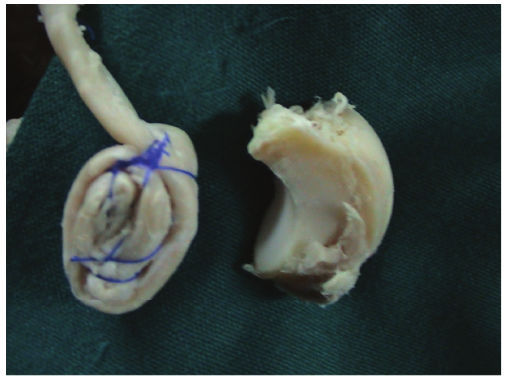
Figure 1: The strip obtained from ECRL and the remaining part of the tendon which will be folded into a coil.